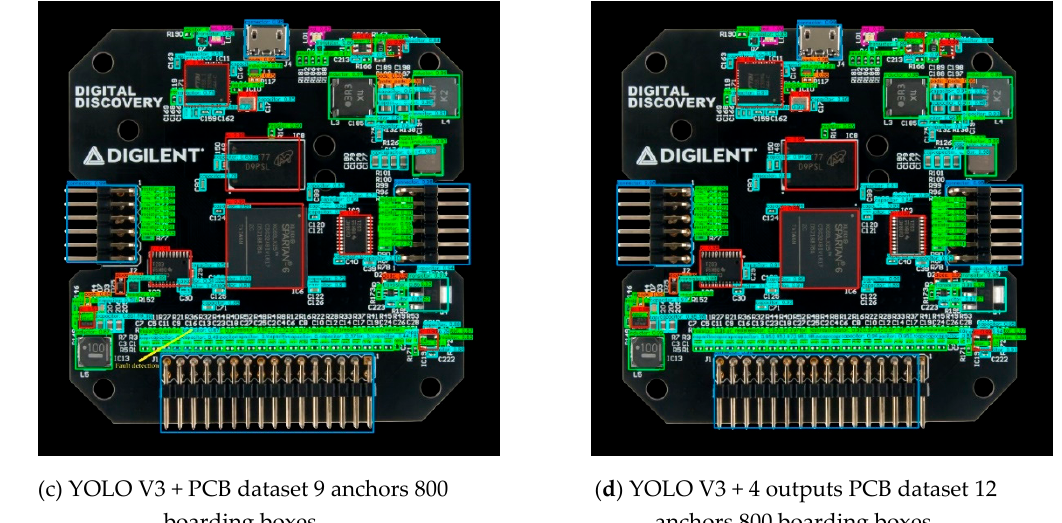
Figure 10. Comparisons of small object detection results between the four algorithms.